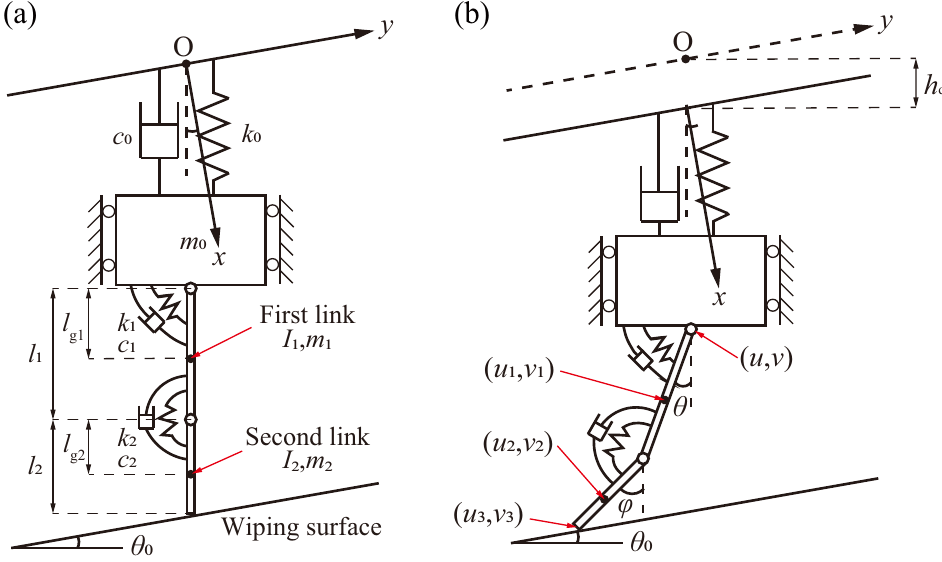
Figure 2. Two-link model of wiper system. ( a ) Upright state; ( b ) buckled